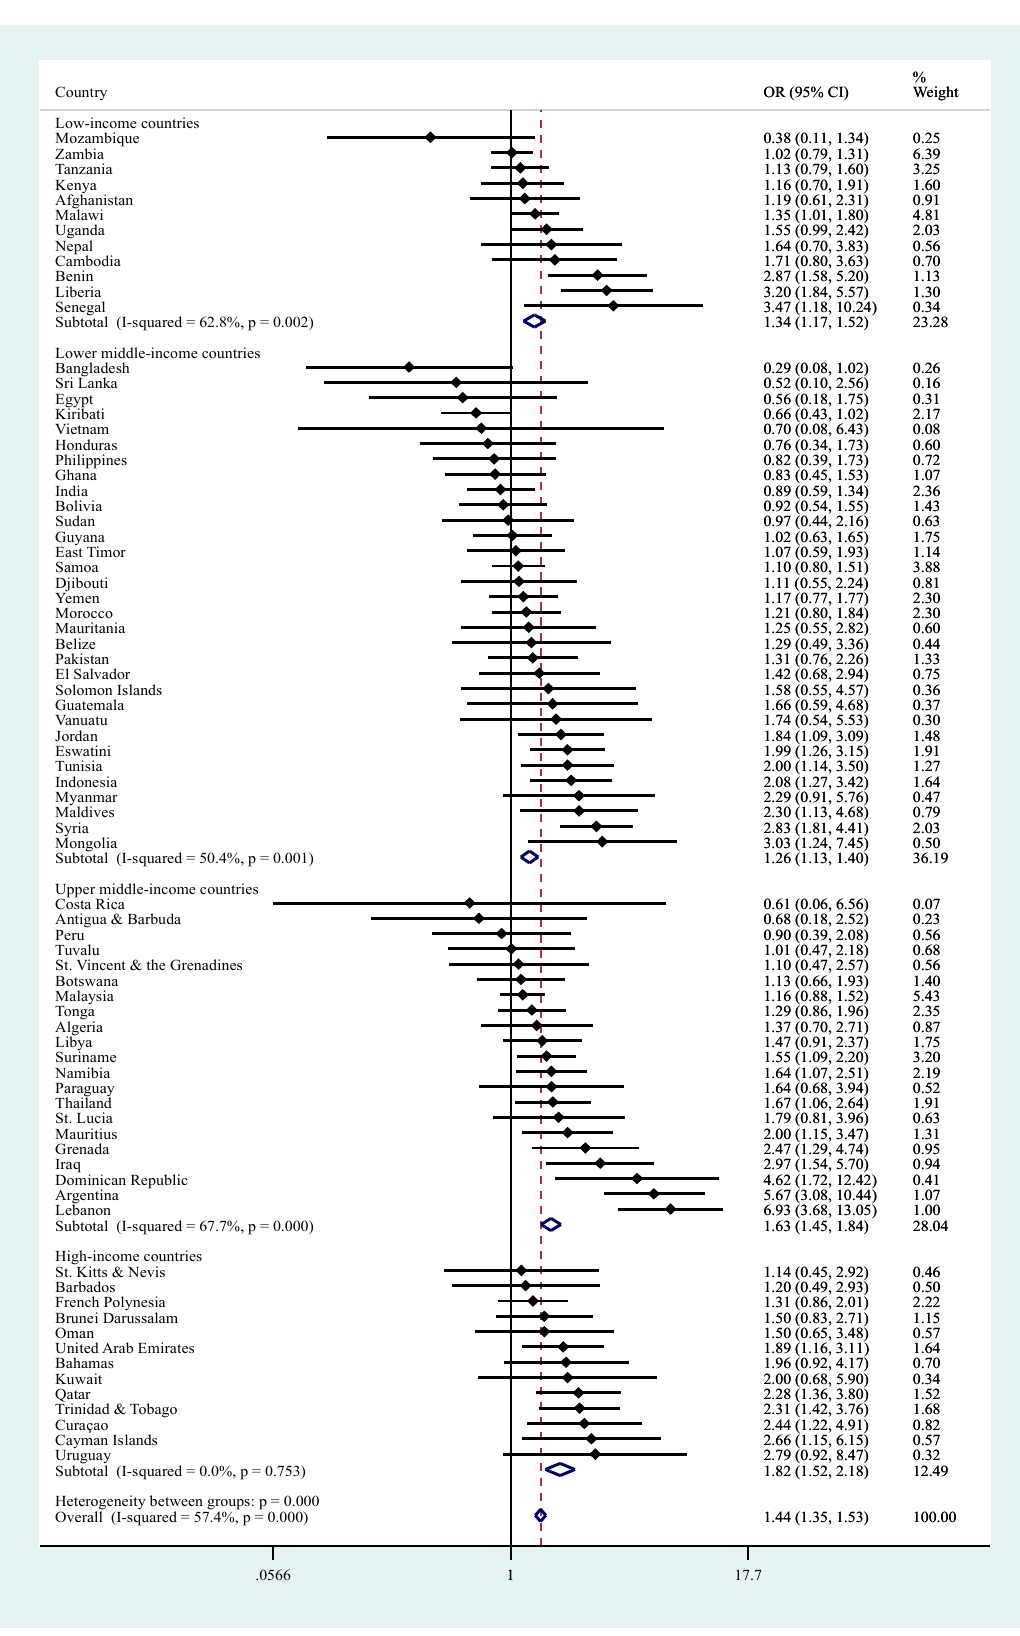
Heterogeneity between groups: p = 0.000 Overall (I-squared = 57.4%, p =